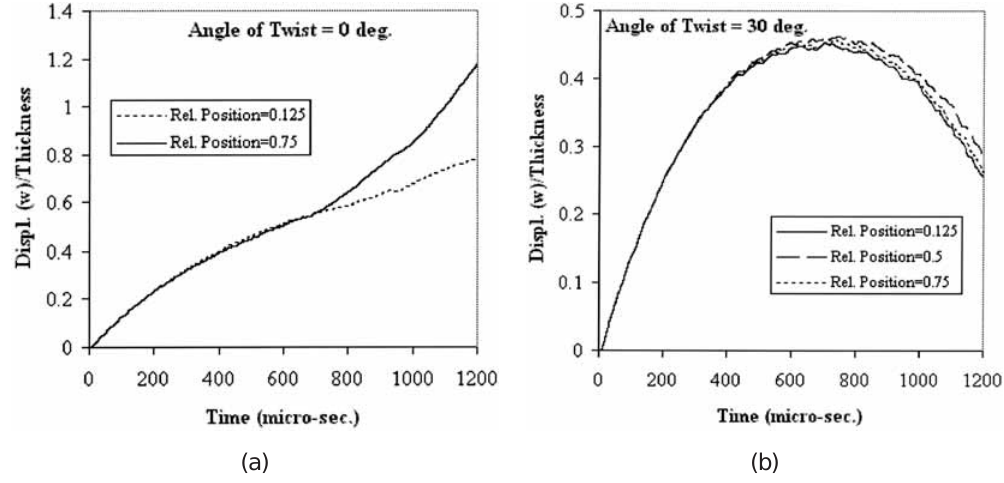
Fig. 7. (a) The effect of relative position of delamination across thickness on central deflection for bending stiff ([0 2 / ± 30] S ) graphite-epoxy composite cantilever cylindrical shell with 25% delamination (relative position of centre line at 0.25 from the free end). (b) The effect of relative position of delamination across thickness on central deflection for bending stiff ([0 2 / ± 30] S ) graphite-epoxy composite twisted cylindrical shell with 25% delamination (relative position of centre line at 0.25 from the free